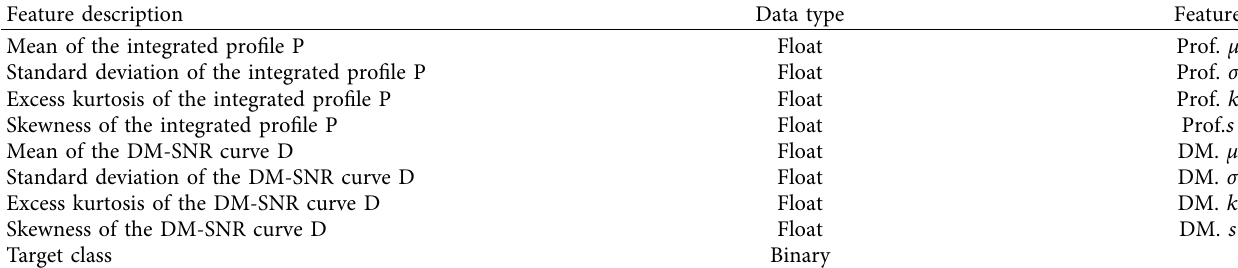
Table 3: Description of features in HTRU2